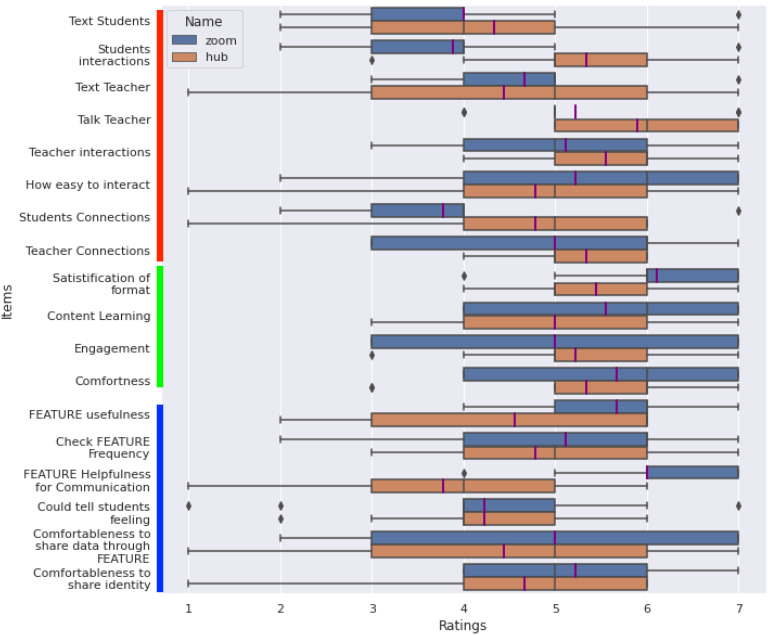
Figure 8. Survey result: Purple line is median. Red section questions are social interactions, green section questions are experience-related, and blue section questions are automated emoji features vs. camera features. Student rating scale of each item from 1 to 7 (strongly disagree to strongly